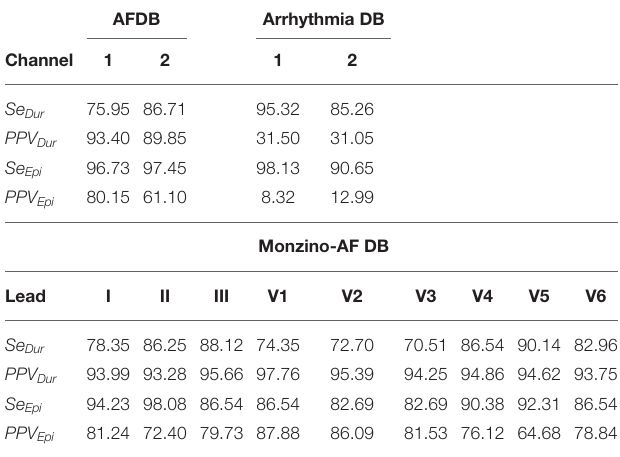
TABLE 8 | Number of AF episodes present in the databases that are shorter than a particular duration.